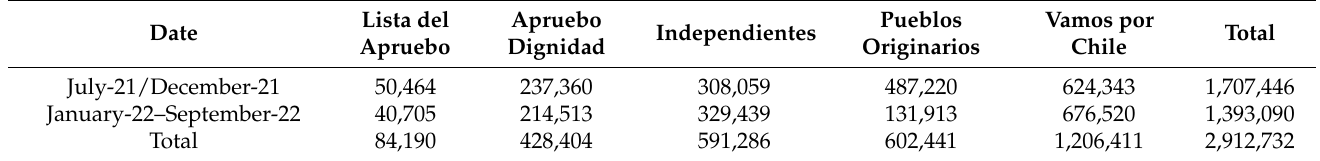
Table 1. General corpus of Twitter messages by electoral list, 2021–2022.